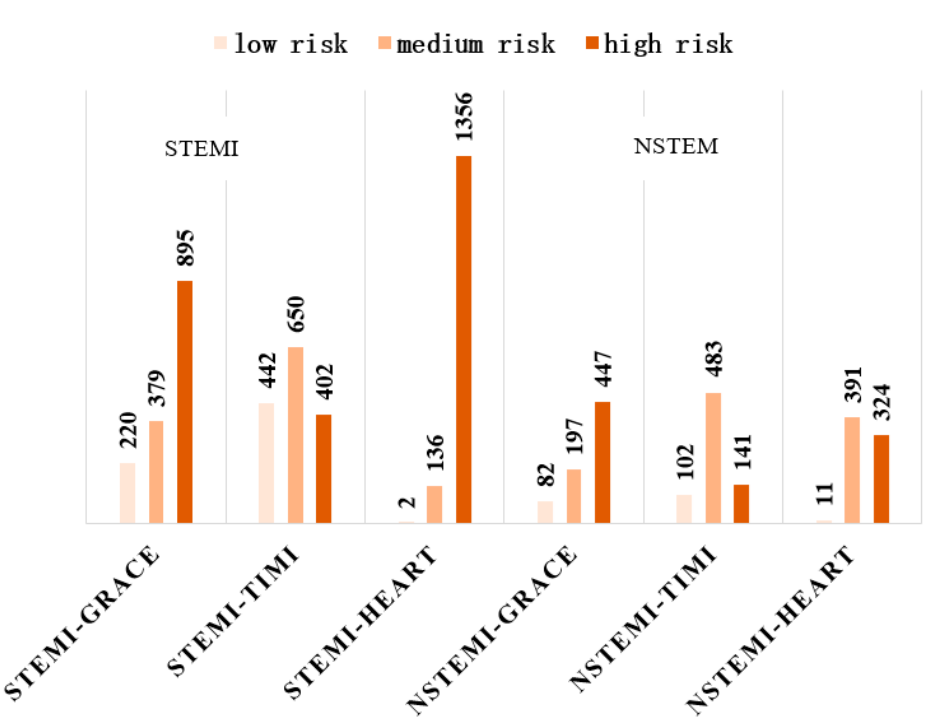
Figure 2. Risk stratification of STEMI and NSTEMI patients in different risk models. Among the STEMI patients, the AUC values of the GRACE score were 0.775, 0.762, 0.740, and 0.734 at 1, 3, and 5 years and by the end of follow-up, respectively. GRACE had significantly higher AUC values than the TIMI score and HEART score at 3 years, 5 years, and at the end of follow-up ( p < 0.05). The TIMI score performed slightly worse than the GRACE score, with AUC values of 0.770, 0.719, 0.702, and 0.675 at the four time points, and significantly higher than the HEART score at 3 years, 5 years, and at the end of follow- up ( p < 0.05). The HEART score performed relatively poorly, with AUC values of 0.719, 0.643, 0.617, and 0.617, respectively. The AUC values for all three scores tended to de- crease over time, but the GRACE score was the most stable overall (Table 3, Figure 3a). Table 3. Comparison of the AUC values for the three risk scores at different time points *. Cumulative Deaths GRACE TIMI